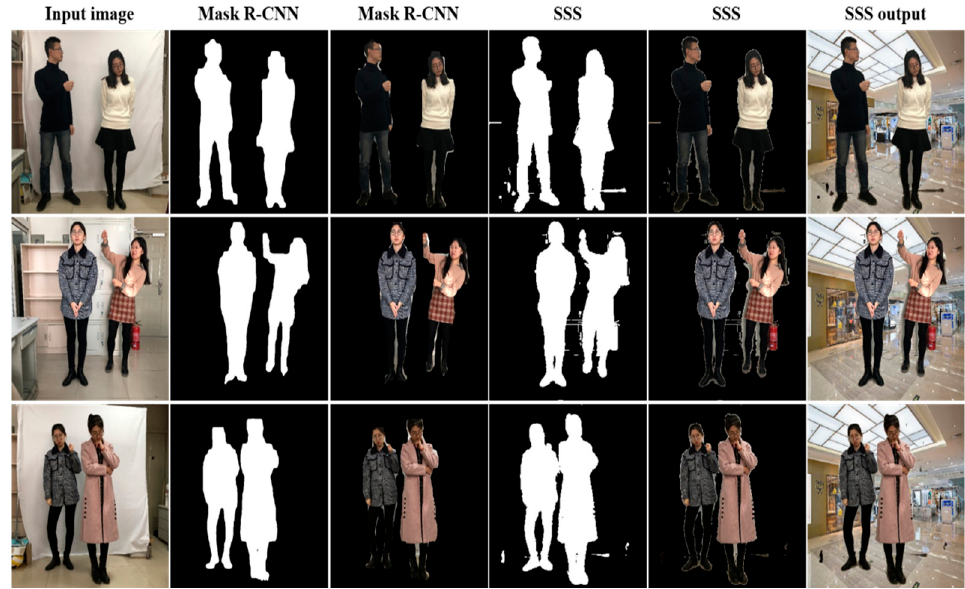
Figure 5. Comparison of the mask R-CNN and semantic soft segmentation (SSS). SSS can reduce the loss of local information.